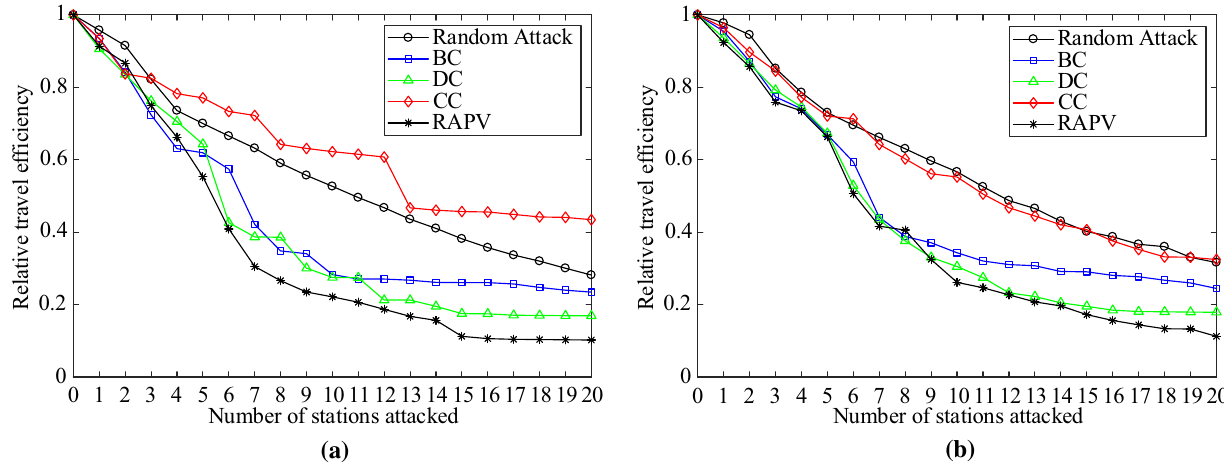
Fig. 4 Passenger travel realization simulation output under five attack modes a during peak hours and b during